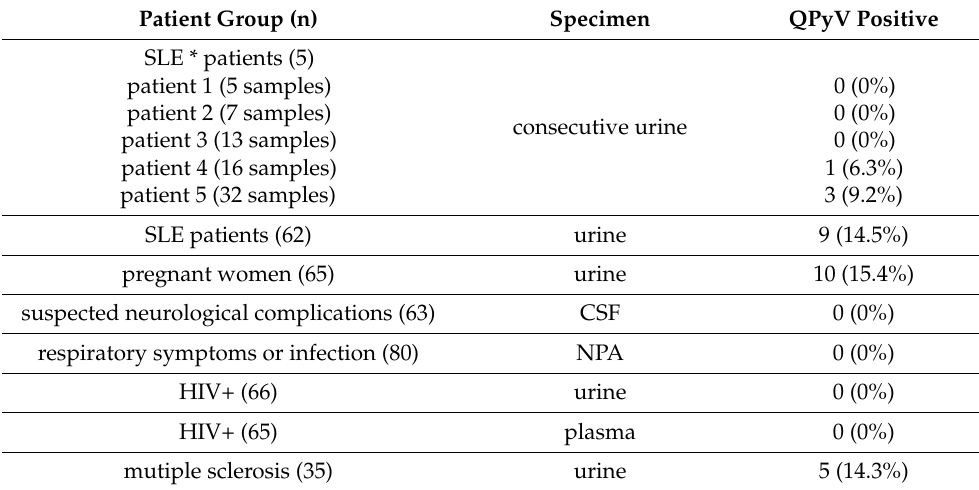
Table 1. Prevalence of QPyV DNA in clinical samples from different patient